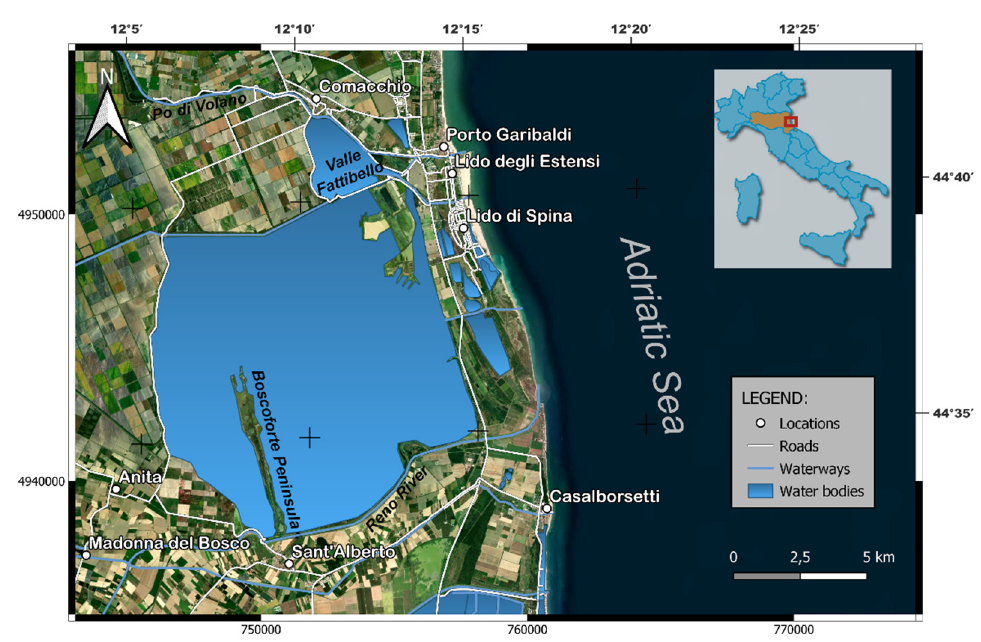
Figure 1. The Valli di Comacchio coastal lagoons study site. Coordinates are represented in ED50 99 UTM Zone 32 N (plain characters) and in Geographical W84 (bold characters).